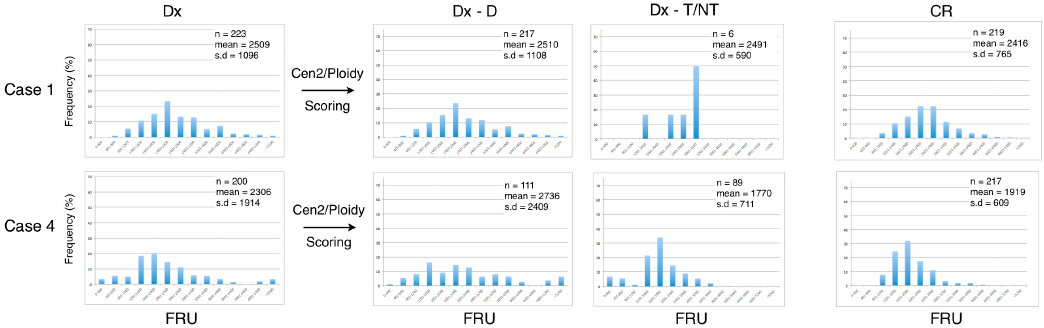
Figure 5. Quantification of telomere content in bone marrow cells at diagnosis (Dx) and at complete remission (CR) in the B-cell disease group. The FRU values were grouped and frequencies were normalized at Dx, and after ploidy scoring into Dx-Diploid and Dx-T/NT nuclei as well as at CR as indicated in Figure 4.